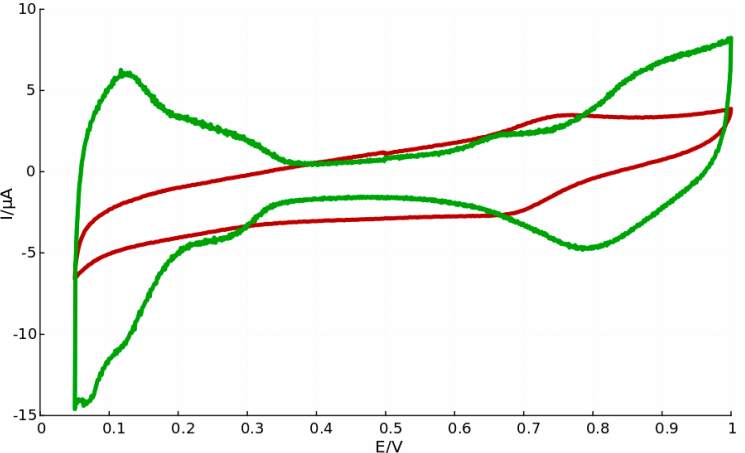
voltammograms for Fe-core Pt-shell